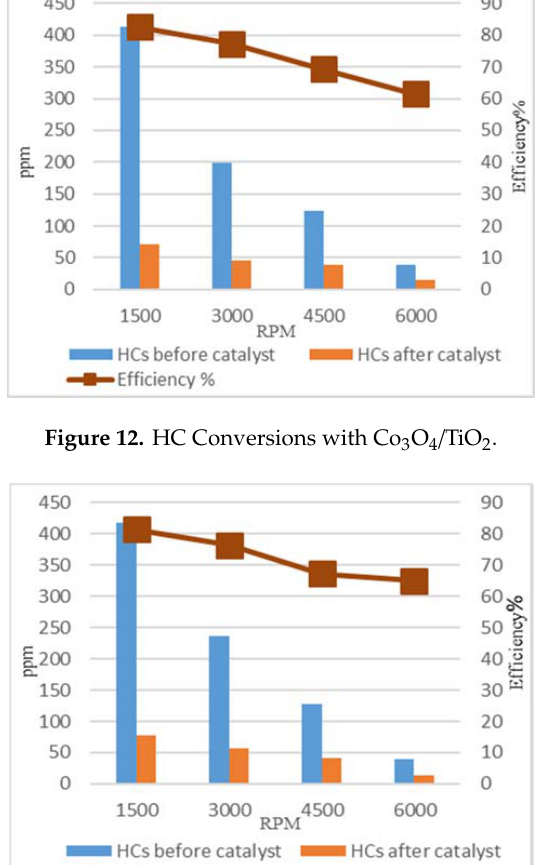
/ TiO 2 - Co 3 O 4 2